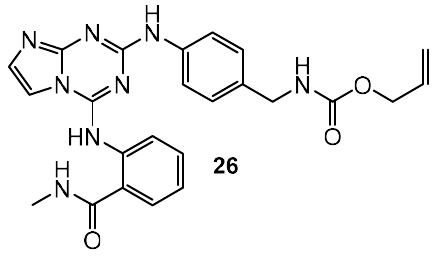
Figure 7. Structure of FAK inhibitor.